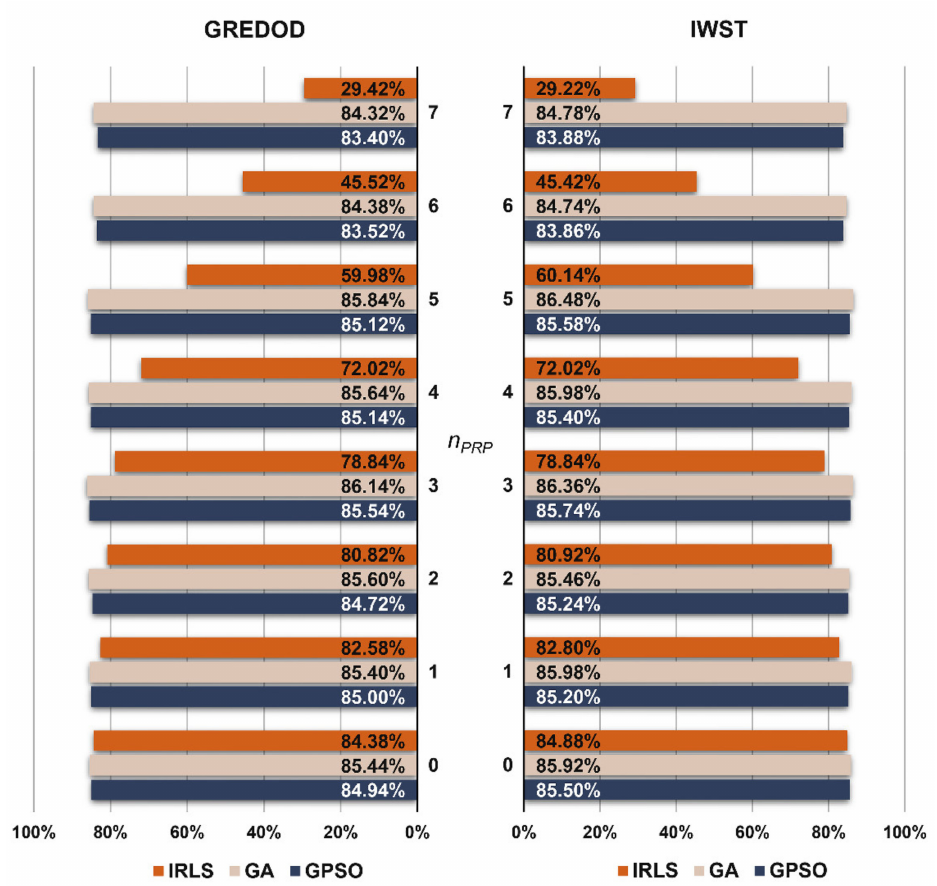
Figure 4. MSRs of GREDOD and IWST methods for variant